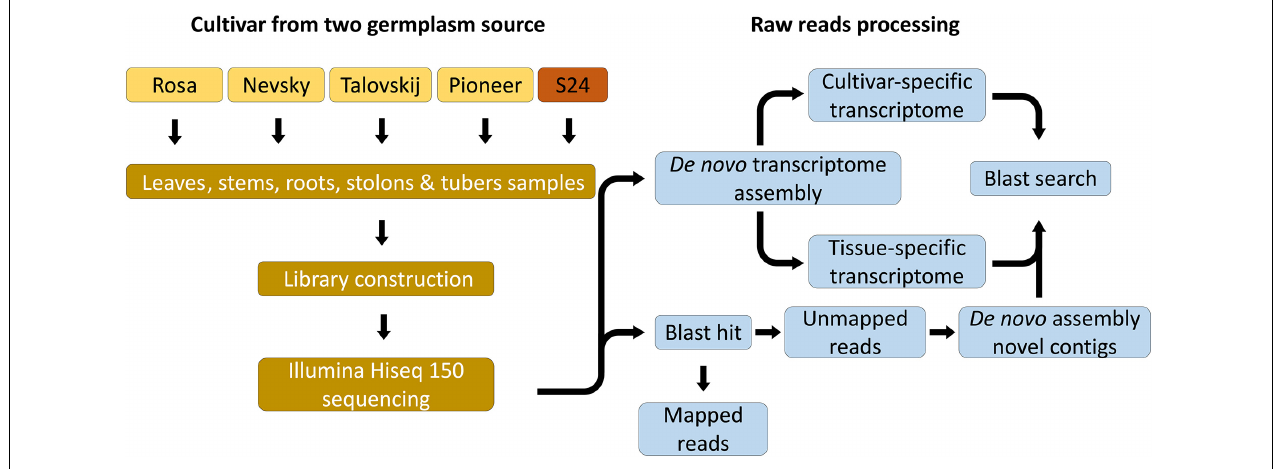
FIGURE 1 | Scheme of bioinformatic analyses for the 22 potato viromes. Two strategies, “align-then-assemble” and “assemble-then-align,” are